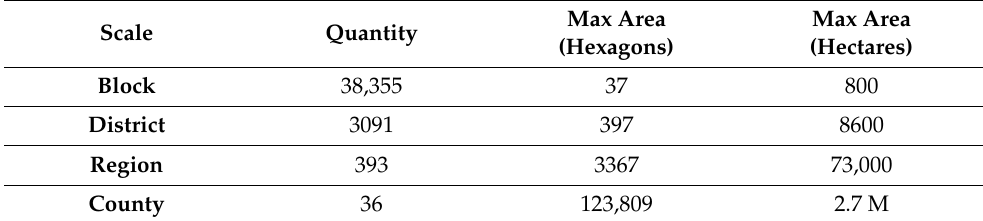
Max Area Max Area (Hexagons) (Hectares)